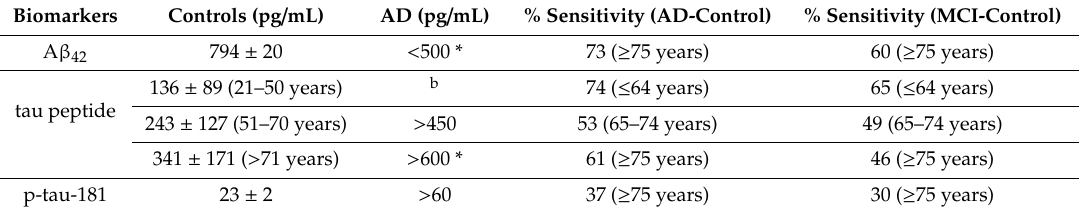
Table 2. Established diagnostic biomarkers in the cerebrospinal fluid CSF of Alzheimer’s